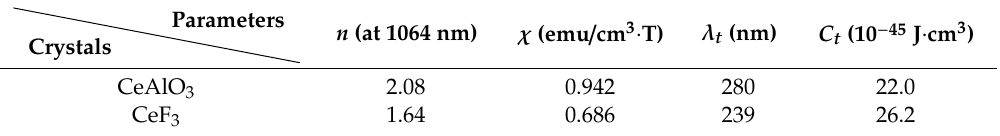
Table 3. The fitting and calculated parameters of two crystals at room temperature according to Equation (2). (The refraction index and volume magnetic susceptibilities are also